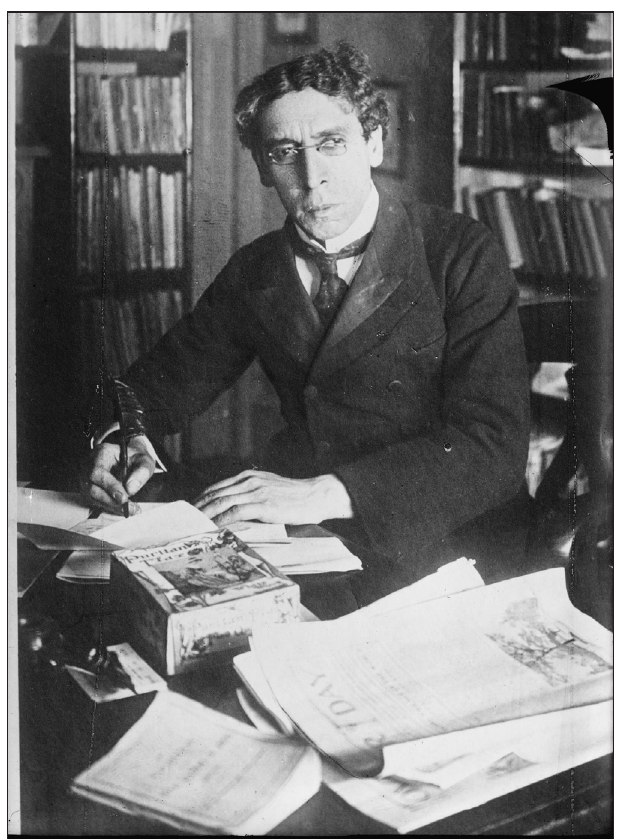
Fig. 1 : Photograph of Israel Zangwill, date unknown, George Grantham Bain Collection, Library of Congress, Washington DC. Wikimedia